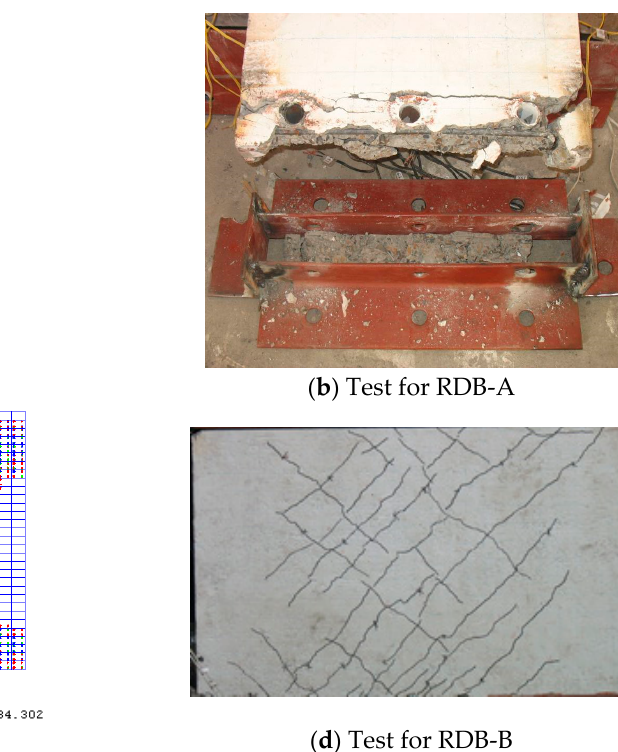
Figure 11. Comparison of the load-displacement relationship between the test and FEM results.